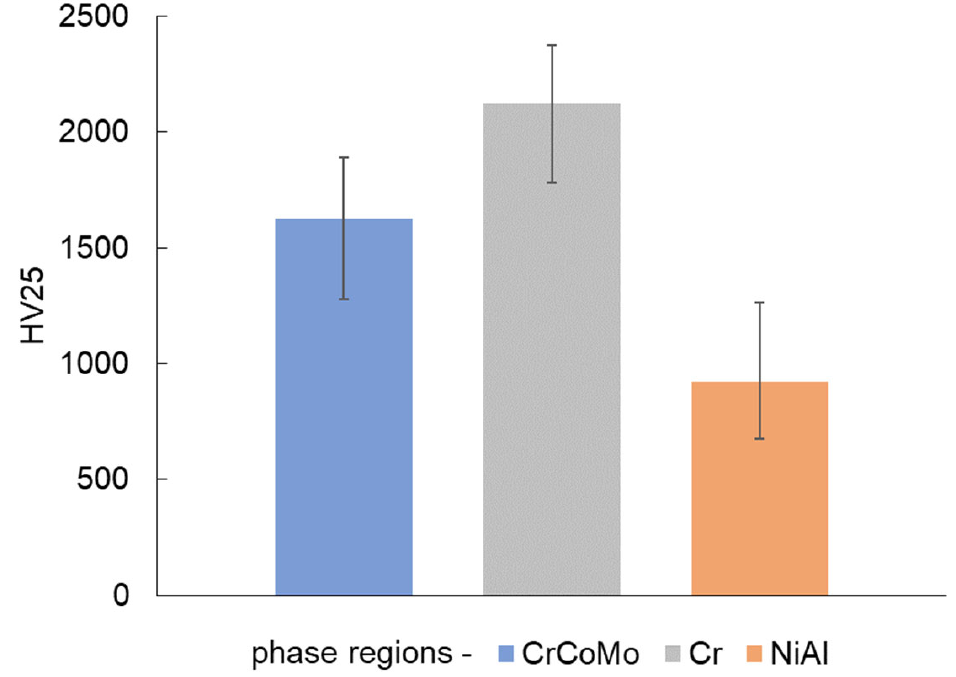
Figure 14. The results of the microhardness measuring of the phase regions of the matrix sample. The results of measuring the bending strength of the alloy samples are shown in Figures 15 and 16a. A sample with a crystalline matrix of NiAlCrMoCo with the addition of 0.01 wt. % nanoparticles of zirconium oxide had the highest strength of 611 MPa at room temperature and 604 MPa at 750 ◦ C. The NiAlCrMoCo crystalline matrix sample had a strength of 504 and 474 MPa, at room temperature and 750 ◦ C, respectively. Strength of single-crystal NiAl was about 305 MPa at room temperature and 429 MPa for heat-treated samples [1]. In [25] material NiAl-13at. % Cr-13at. % Mo-0.1 wt.% ZrO 2 prepared in a similar way had the bending strength of 201 MPa at room temperature, and 473 MPa at 700 ◦